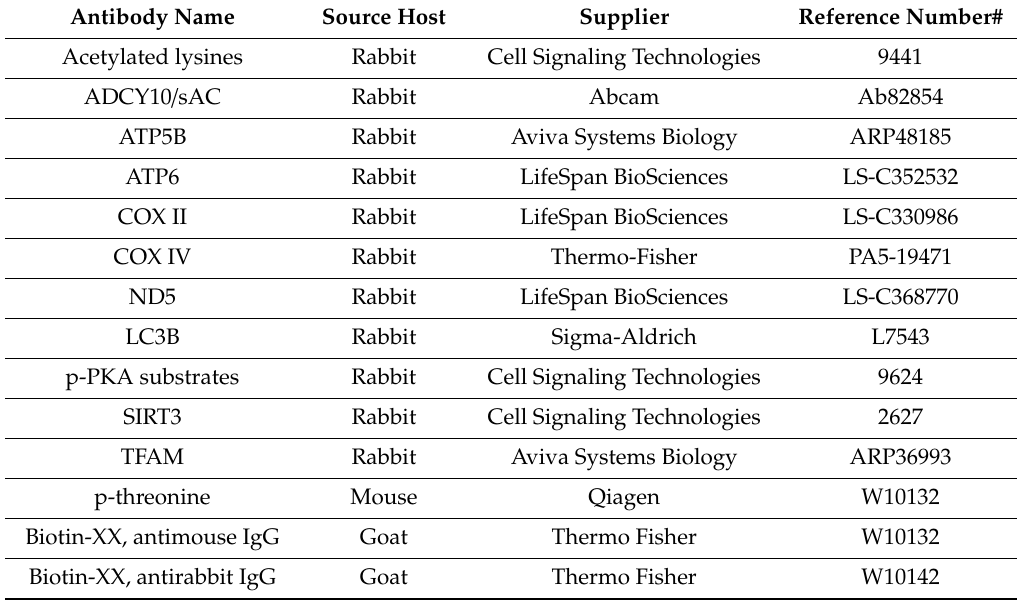
Table 2. List of antibodies used for Western